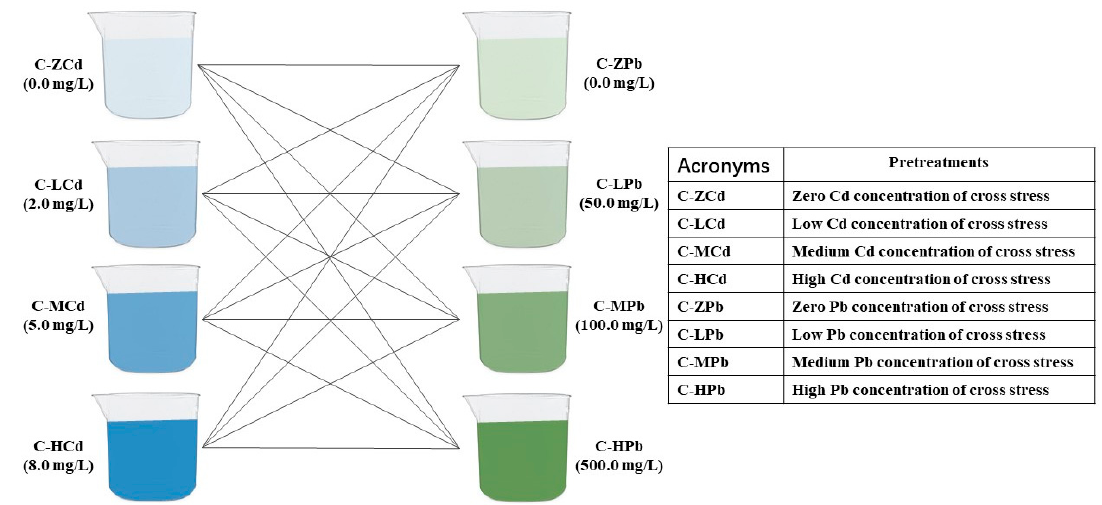
Figure 1. Cadmium-Lead (Cd–Pb) concentrations, the corresponding abbreviations and combined details.